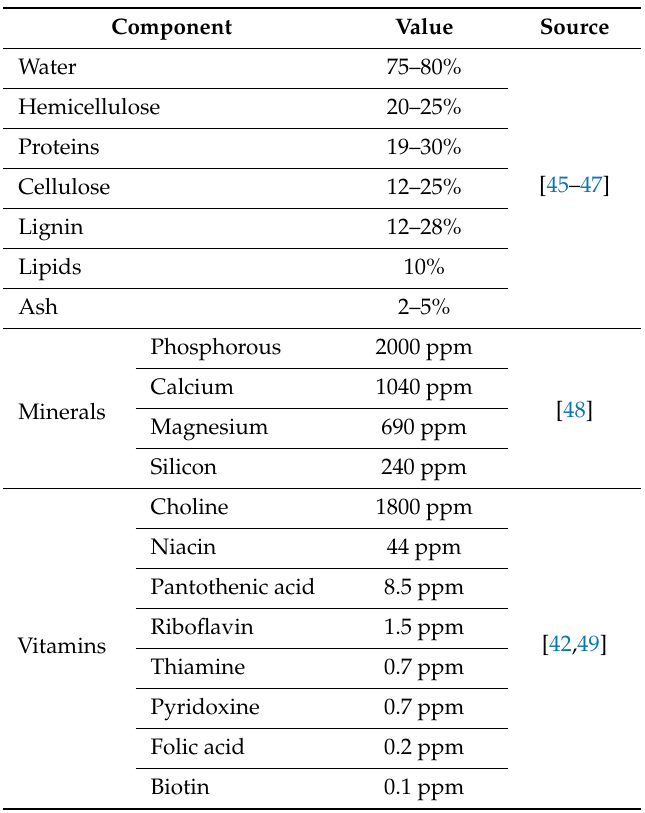
Table 2. Chemical composition of brewer’s spent grain according to di ff erent